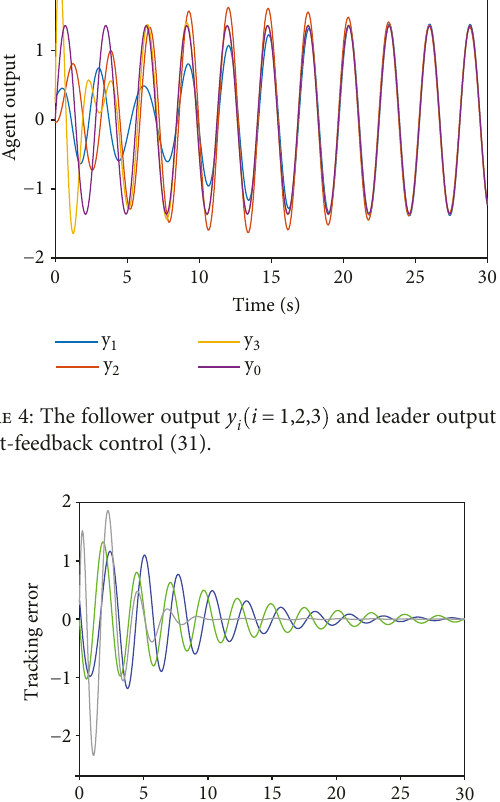
i = 1,2,3 and leader output y i